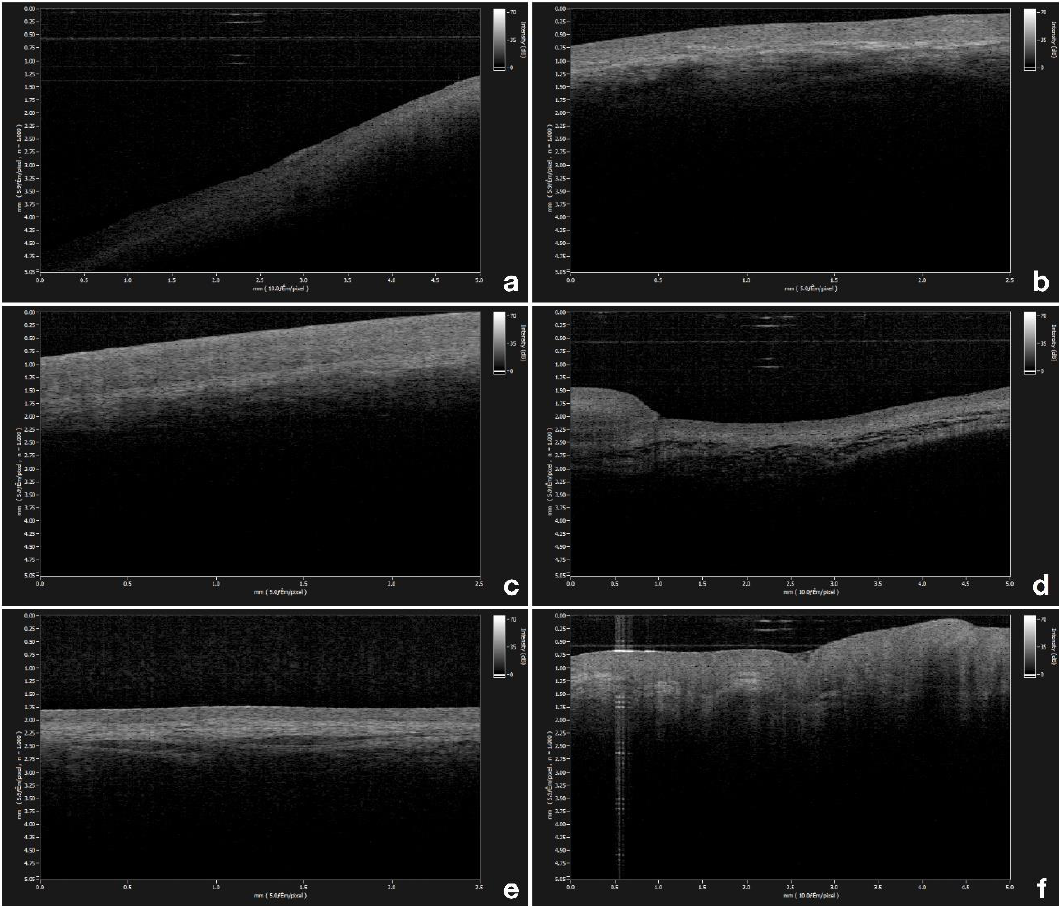
Figure 1. ( a ) Optical coherence tomography (OCT) image of healthy gingiva; ( b ) OCT image of healthy labial mucosa; ( c ) OCT image of healthy buccal mucosa; ( d ) OCT image of healthy ventral surface of the tongue; ( e ) OCT image of healthy floor of the mouth; ( f ) OCT image of healthy tongue dorsum.